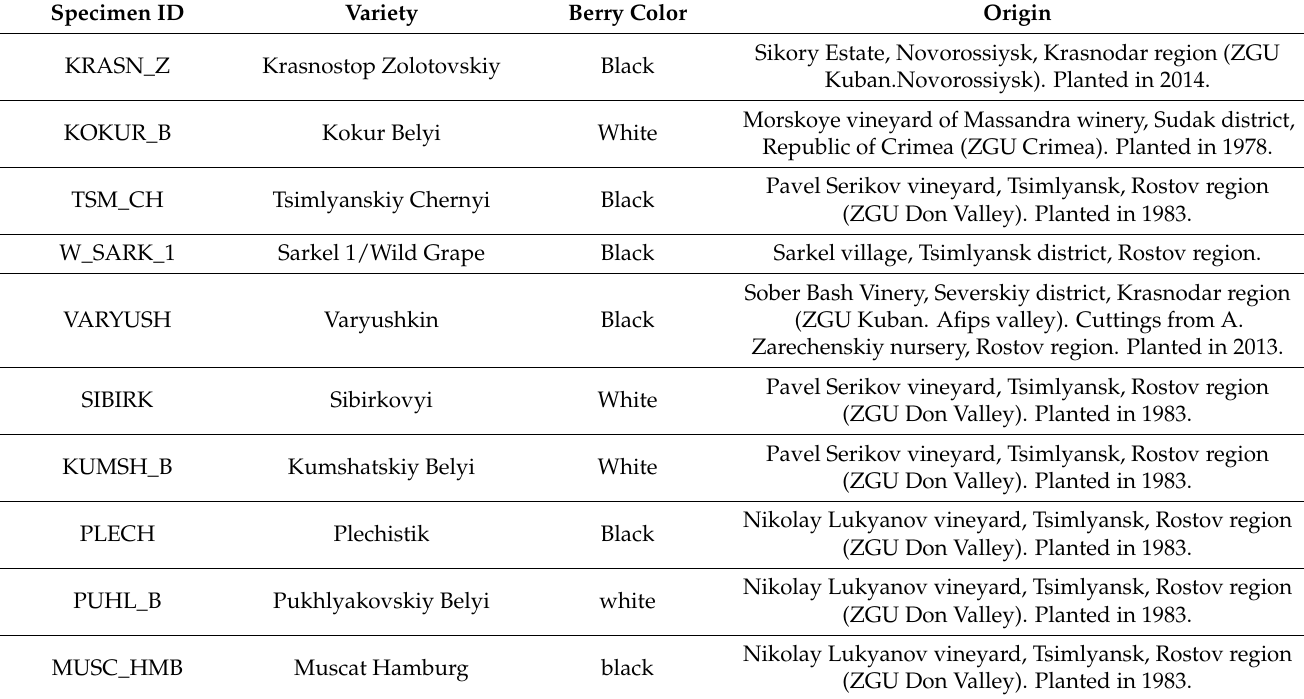
Table 5. Genotyped V. vinifera